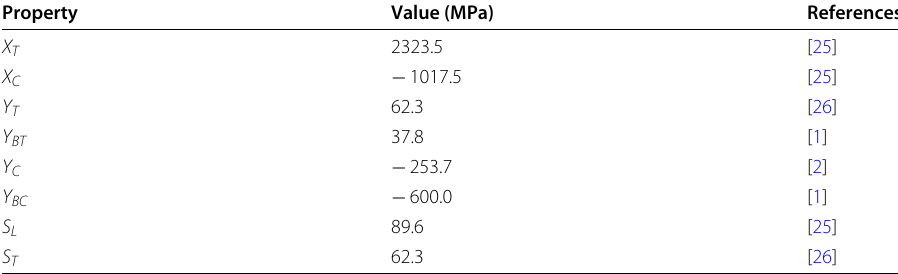
Table 3 IM7-8552 material properties used to compute the failure envelopes using the IQC Property Value